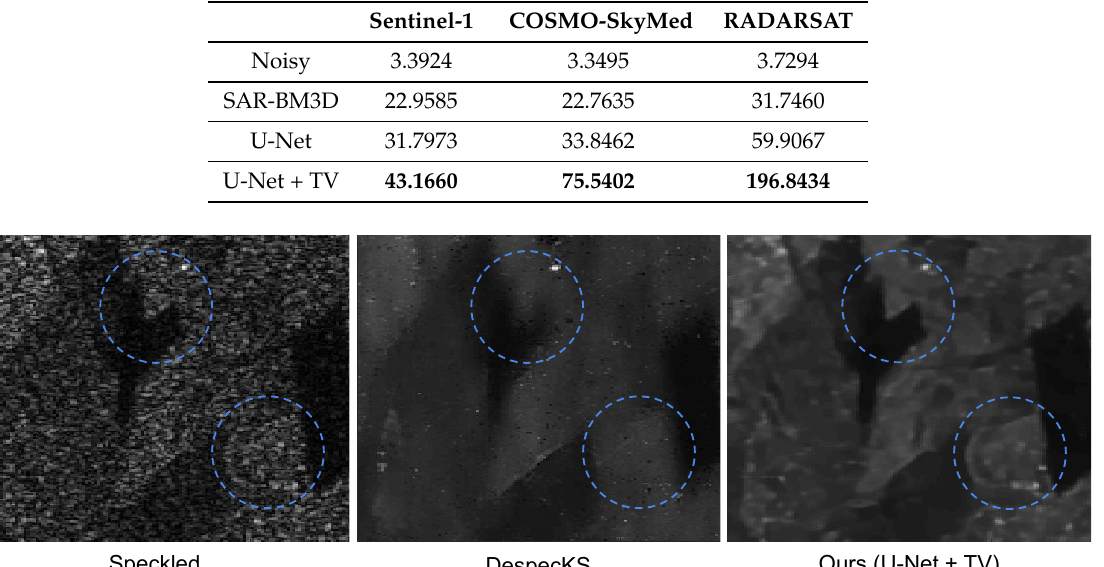
Figure 9. Qualitative comparison between the proposed method and the DespecKS multi-temporal algorithm. The regions within the blue circles highlight the main differences between the two